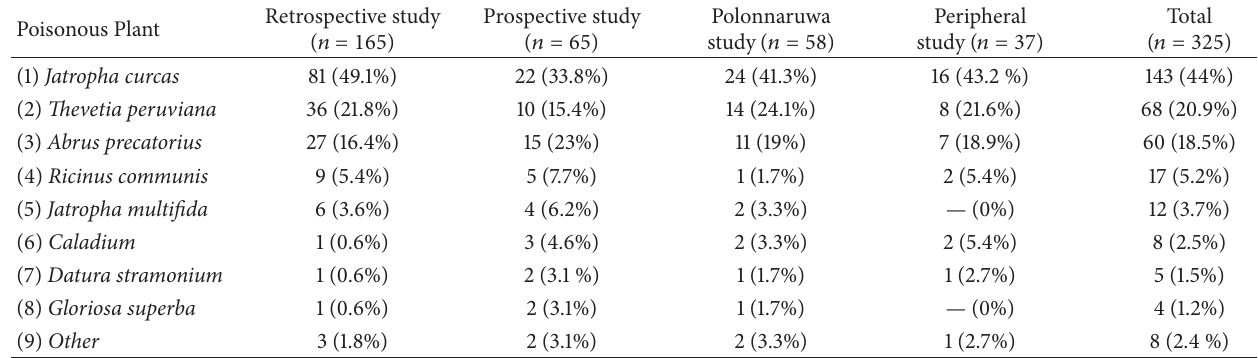
Table 2: Patterns of poisoning with poisonous plants among children in North-Central province. Poisonous Plant